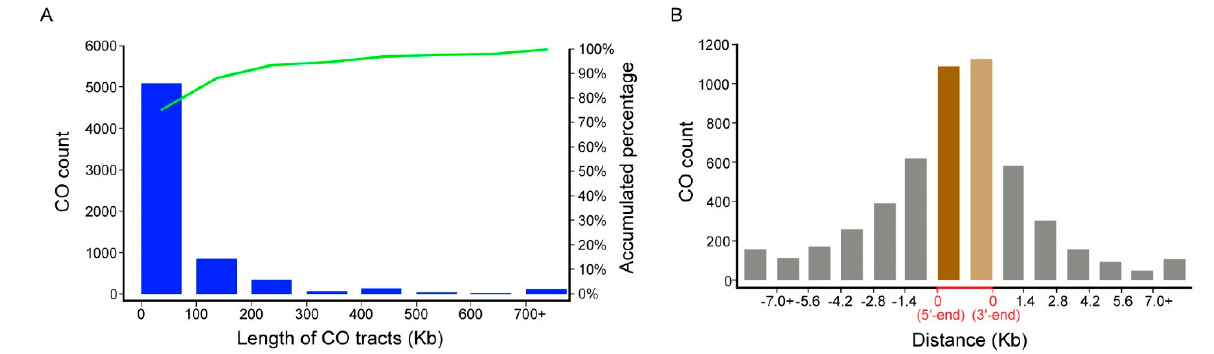
Figure 3. The lengths of CO and the relationships between the gene positions and CO locations. ( A ) CO tract lengths and their accumulated percentage. The scale distance is 100 Kb, and 700+ indicates a CO length greater than 700 Kb. ( B ) Potential relationships between the CO locations and gene positions. The dark brown bar indicates the number of COs close to TSS in the coding regions; the light brown bar represents the number of COs close to TTS in the coding regions; the gray bars indicate the number of COs close to TSS or TTS in the non-coding regions. The scale distance was set to 1.4 kb because the average transcript length is about 2.8 kb in the ZS11 reference genome; here, we used the median position of each CO to infer the relationships.